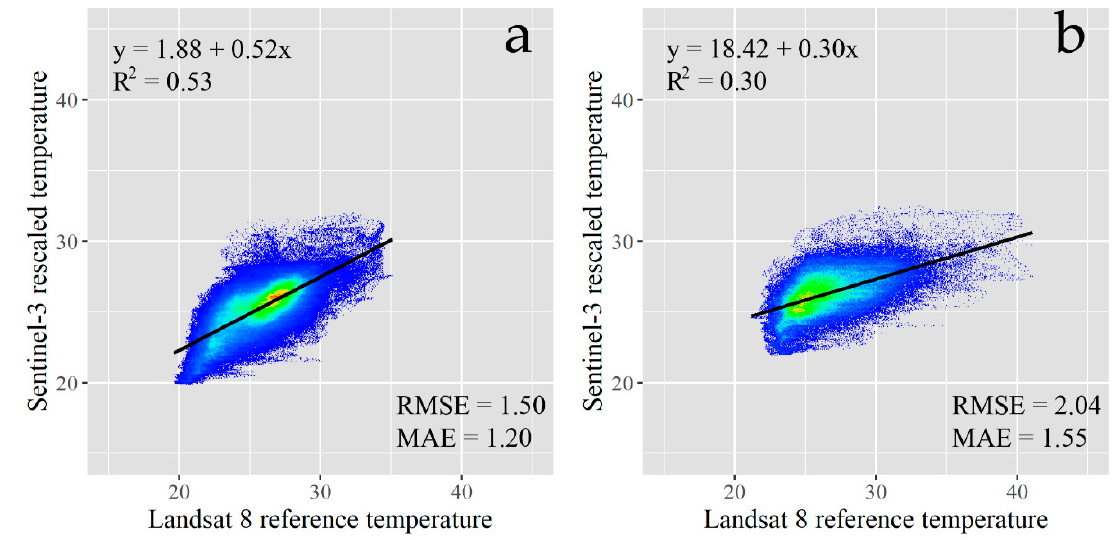
Figure 9. Relationship between two reference Landsat 8 and resampled Sentinel-3 BTs at a fine spatial resolution (60 m) for ( a ) Site 1 and ( b ) Site 2. The solid black line represents the regression line and the dashed red line is the 1:1 line.